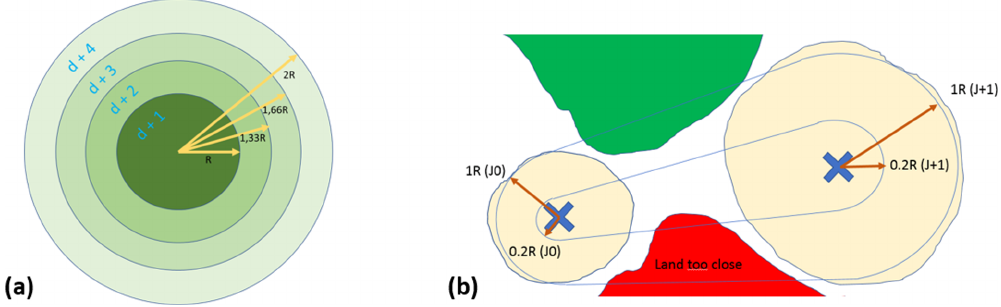
Figure 1. Tracking parameters in META2.0. (a) Increasing the restricted area to solve the missing eddy problem. (b) Land management used to avoid eddies crossing